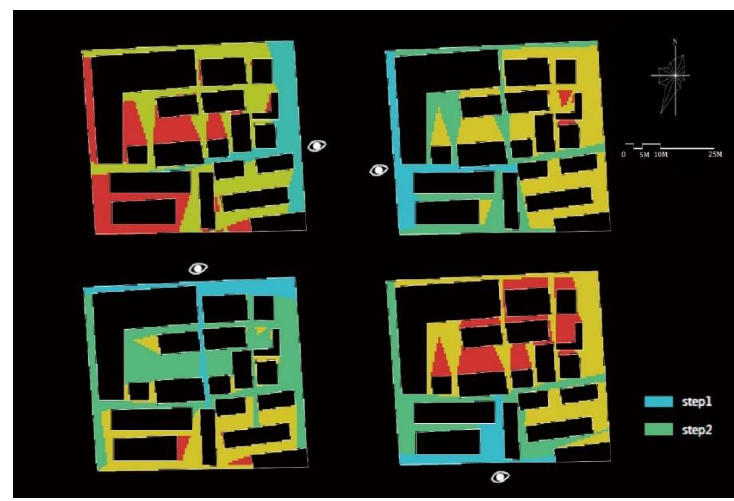
Figure 6. Visibility graph analysis (VGA) of the highlighted block in Figure 5 (step1 denotes the most likely selected space for a tourist at the location of the eye symbol and step2 denotes the most likely selected space for tourists after step1.).